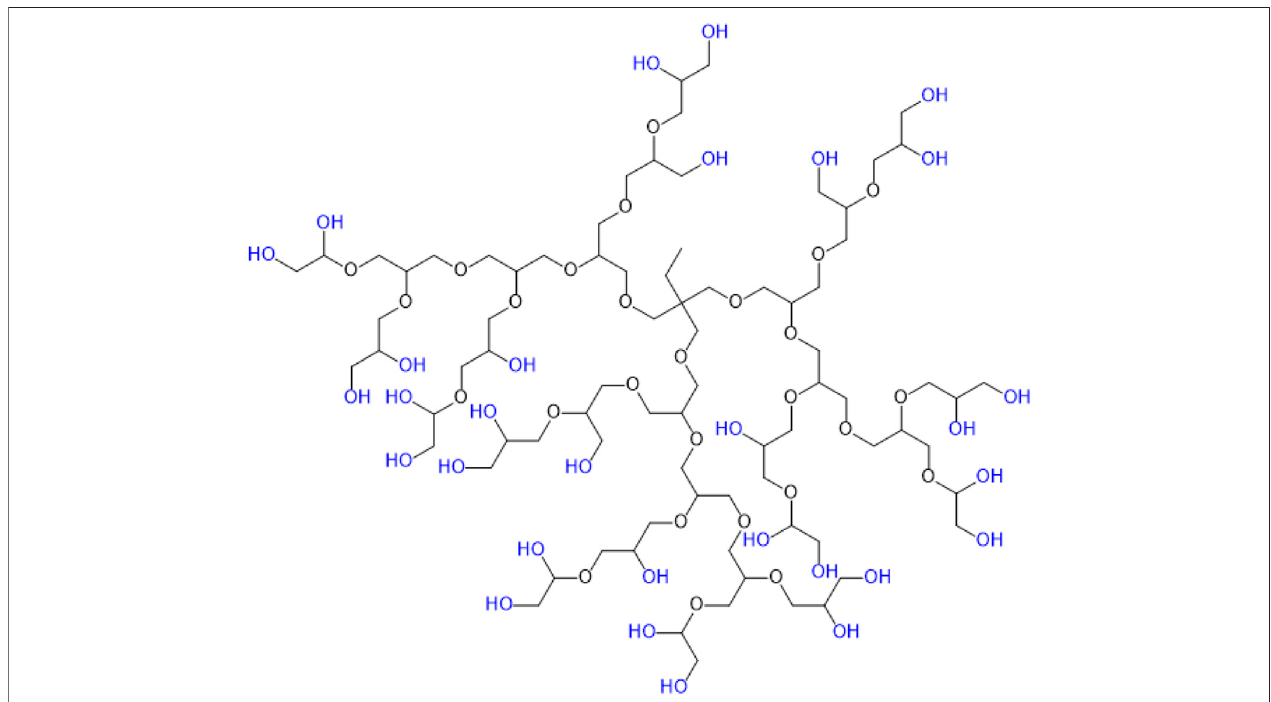
FIGURE 12 | Spherical parent nucleus (HPG) (Chen et al.,